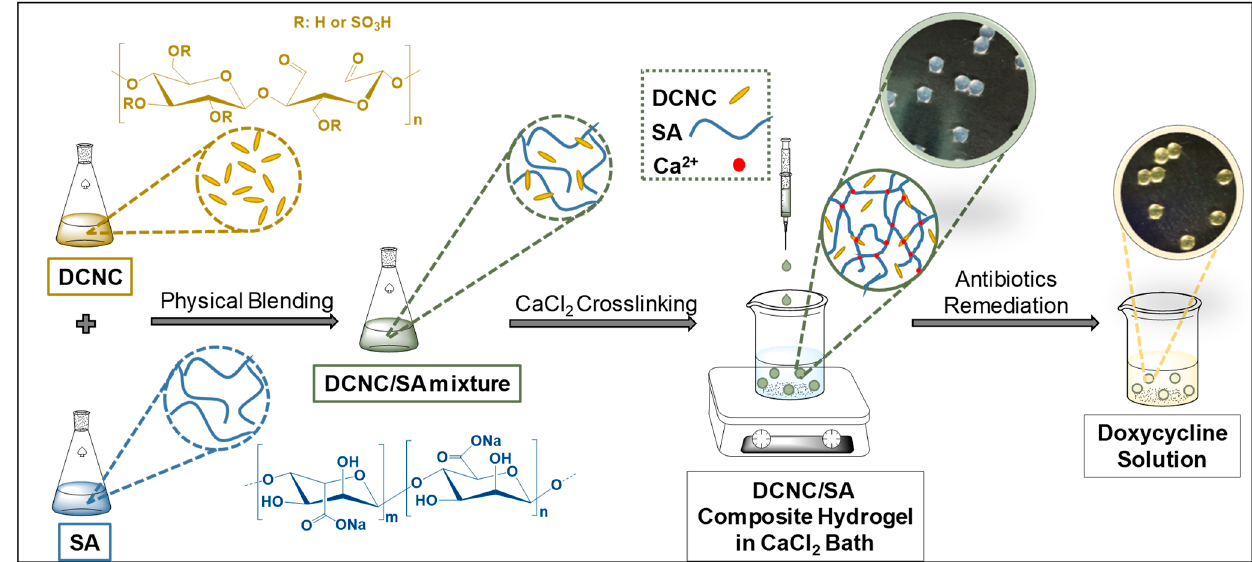
Figure 2. Schematic illustration of the fabrication of SA–DCNC composite hydrogel beads and doxycycline remediation.